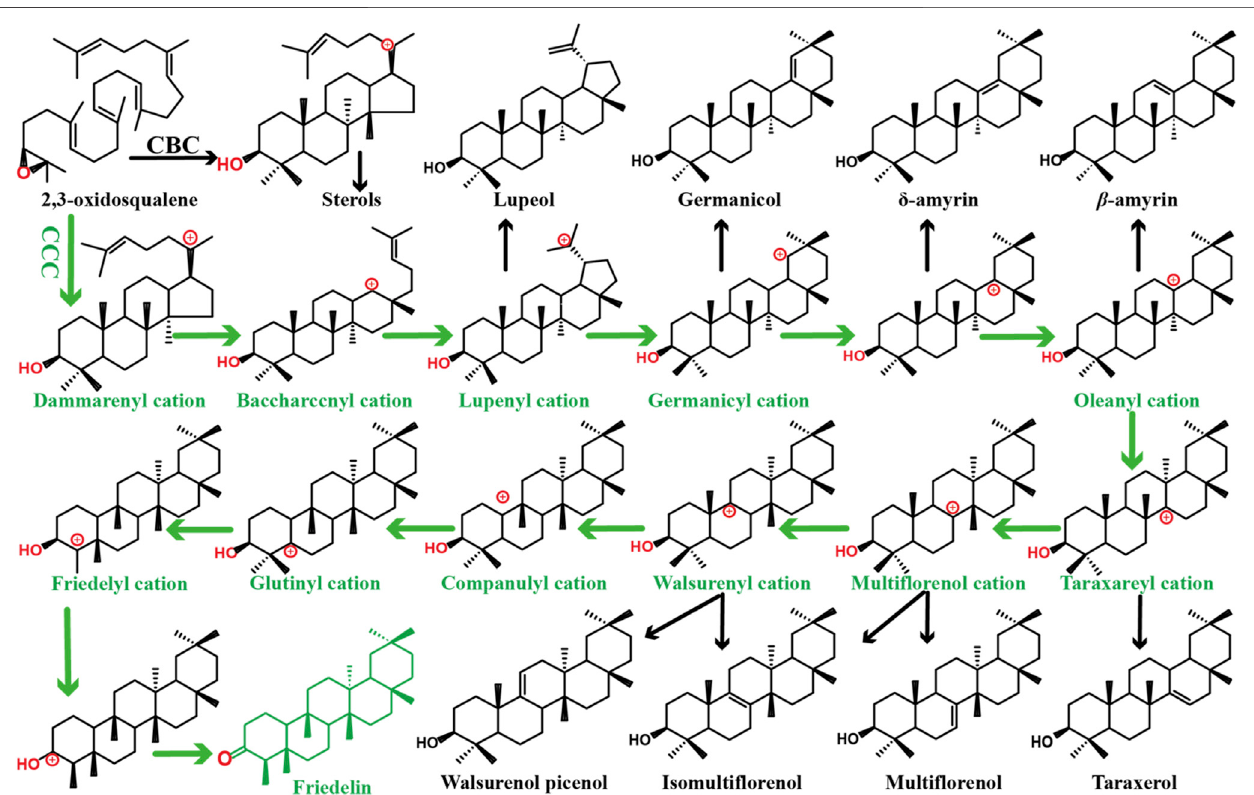
FIGURE1| Mechanismforthecyclizationof2,3-oxidosqualeneintothemostrearrangedpentacyclicfriedelinanddiversetriterpenoidskeletons.Thegreenarrows indicate rearrangement steps including 2,3-oxidosqualene protonation, cyclization, several rearrangements, and deprotonation. The black arrows represent the formation of other triterpenoid skeletons. C – C – C, chair – chair – chair; C – B – C, chair – boat –